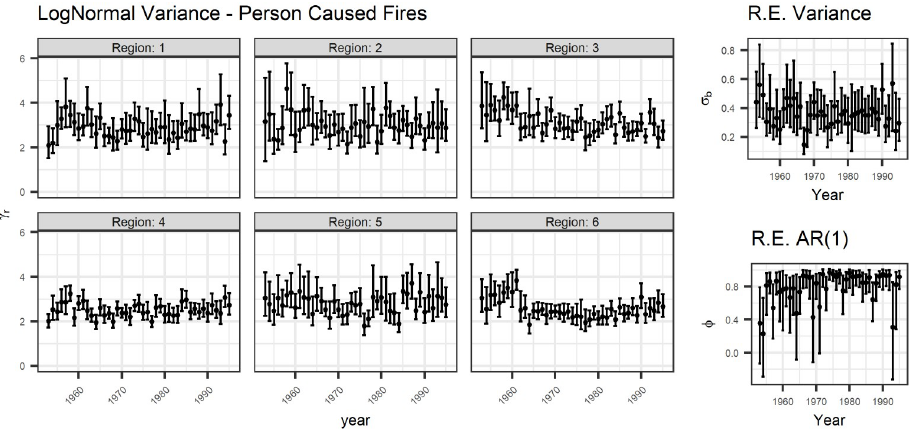
Fig 8. Variance parameters for person-caused fires. Again, there is a slight decrease in the estimates for region 5 and σ b with an increase in the AR(1)